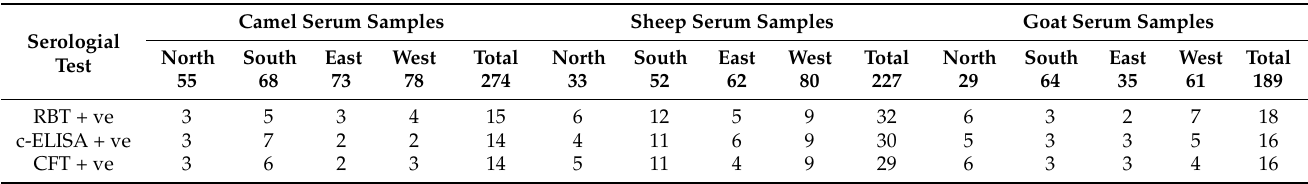
Table 2. Detailed profile of serological immunoassays in different animal species.